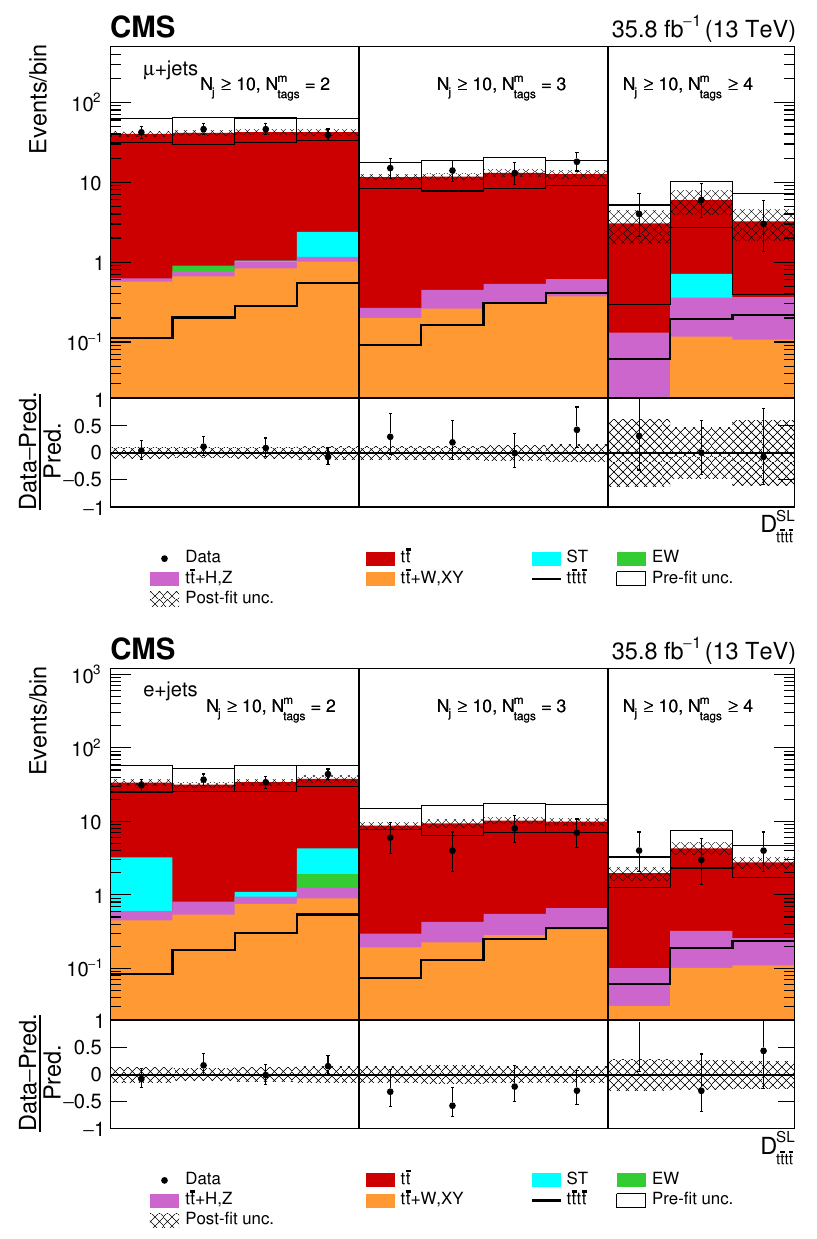
Figure 9 . Post-(cid:12)t D SL distribution in the (upper row) single-muon and (lower row) single- tttt electron channels for events satisfying baseline single-lepton selection and N (cid:21) 10, N m = 2, 3, j tags (cid:21) 4. Non-uniform binning of the BDT discriminant was chosen to achieve approximately uniform distribution of the tt background. Dots represent data. Vertical error bars show the statistical uncertainties in data. The post-(cid:12)t background predictions are shown as shaded histograms. Open boxes demonstrate the size of the pre-(cid:12)t uncertainty in the total background and are centered around the pre-(cid:12)t expectation value of the prediction. The hatched area shows the size of the post-(cid:12)t uncertainty in the background prediction. The signal histogram template is shown as a solid line. The lower panel shows the relative di(cid:11)erence of the observed number of events over the post-(cid:12)t background